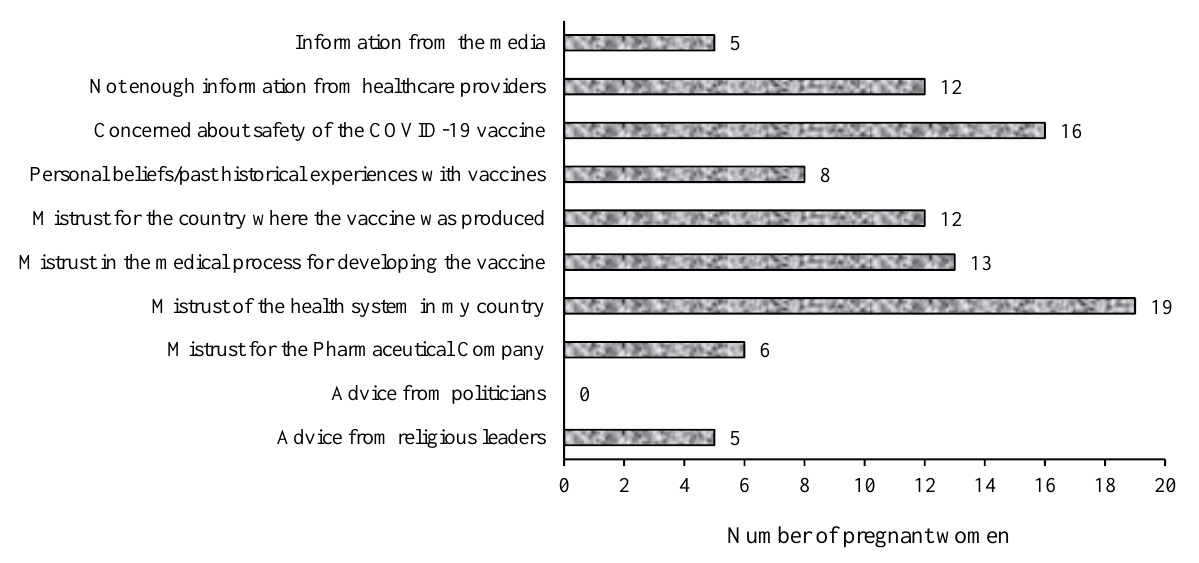
Figure 4. Reasons for non-vaccination against COVID-19 among pregnant women. participants selected multiple